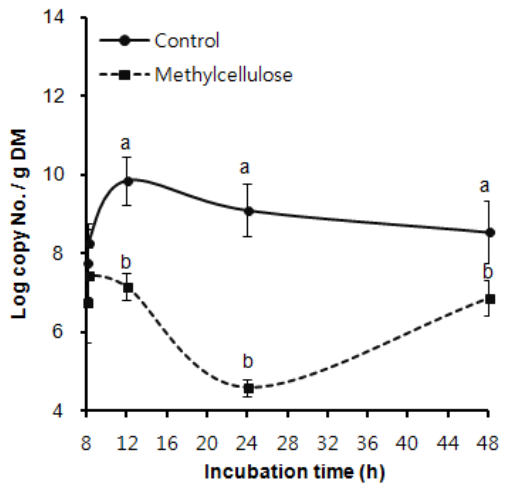
Figure 2. Detachment of Ruminococcus albus on rice straw as influenced by MC addition after 8 h of incubation. a,b Means with different letters differ significantly (p<0.05).